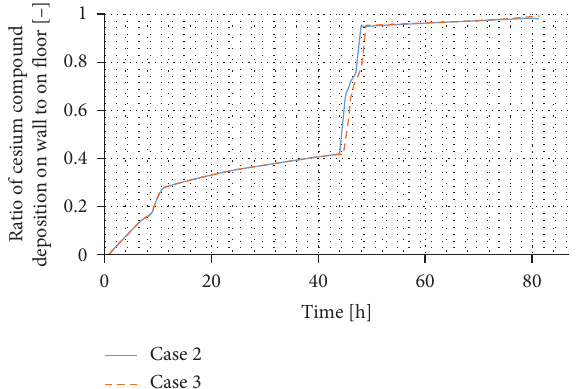
Figure 16: Comparison of the ratios of deposition on the wall to deposition on the floor within Units 1–3 of case 2 and case